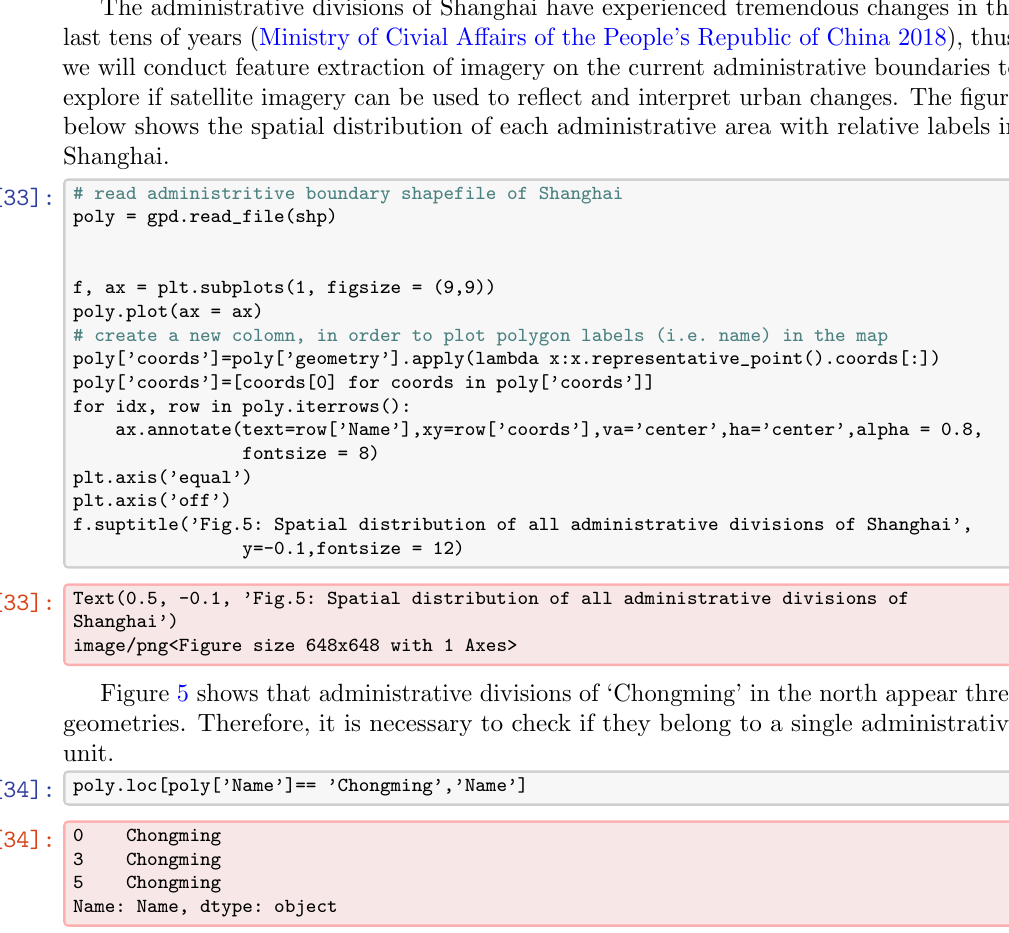
f.suptitle(’Fig.5: Spatial distribution of all administrative divisions of Shanghai’, y=-0.1,fontsize =